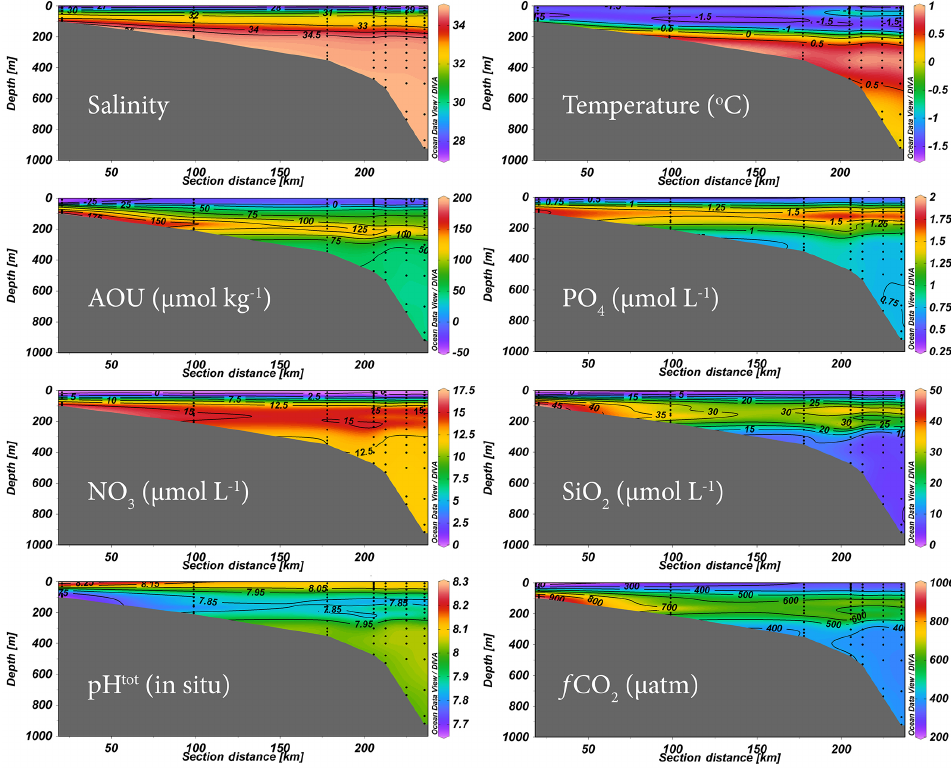
Figure 3. Properties in the upper 1000m along section D of Fig. 1. Sections drawn using Ocean Data View (Schlitzer, 2017).